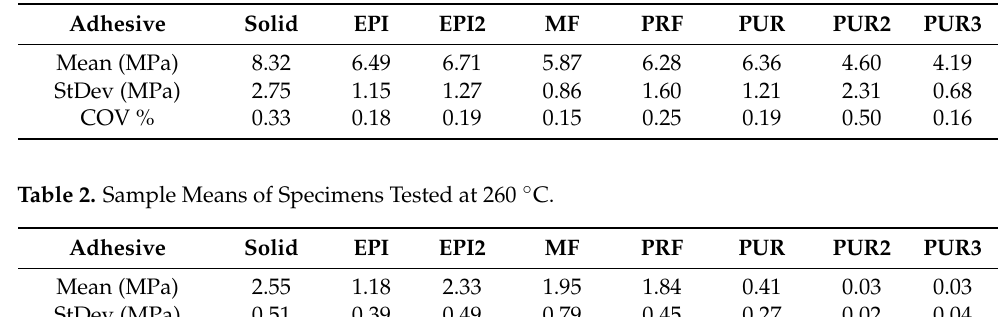
Figure 4. ( a ) Maximum shear stress at 25 ◦ C. Letters at the top of the figure represent groupings from the Tukey Test. ( b ) Maximum shear stress at 260 ◦ C. Letters at the top of the figure represent groupings from the Kruskalmc test. Whiskers represent the minimum and maximum and any dots ( ◦ ) above or below are considered outliers Table 1. Sample Means of Specimens Tested at 25 ◦ C.